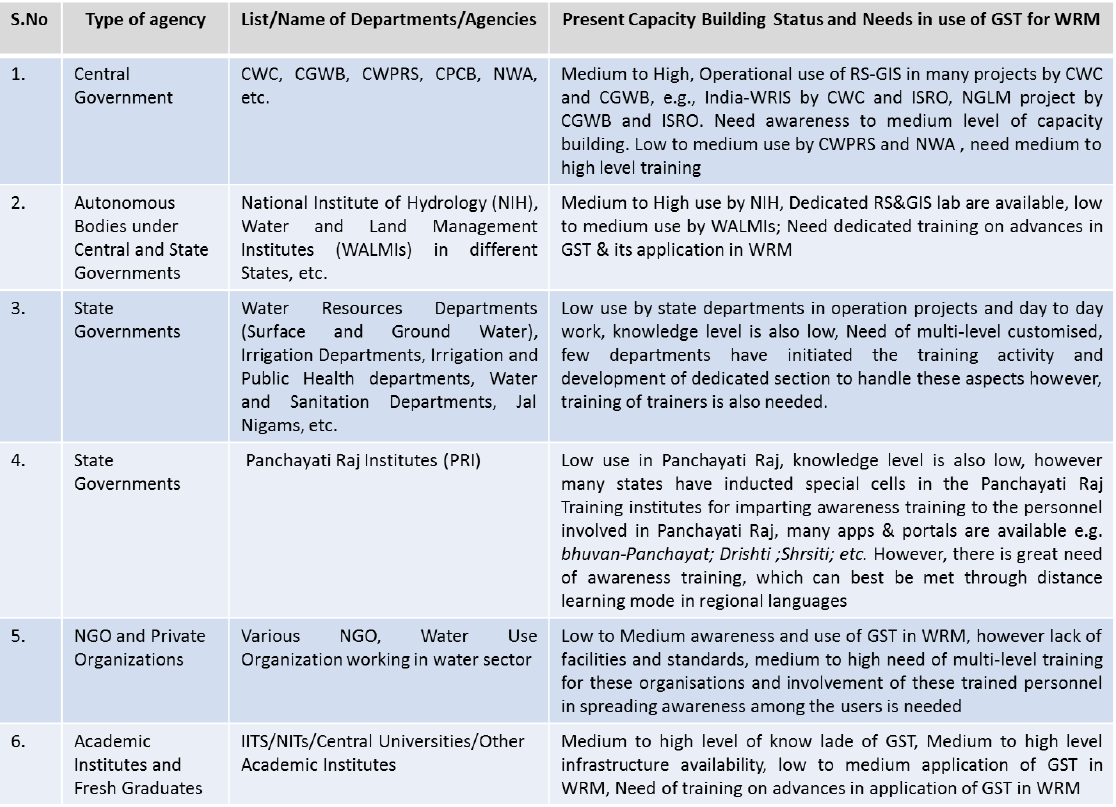
Table 1. Summary of present capacity building status and needs in different organisation and agencies in the country. 3. DIFFERENT